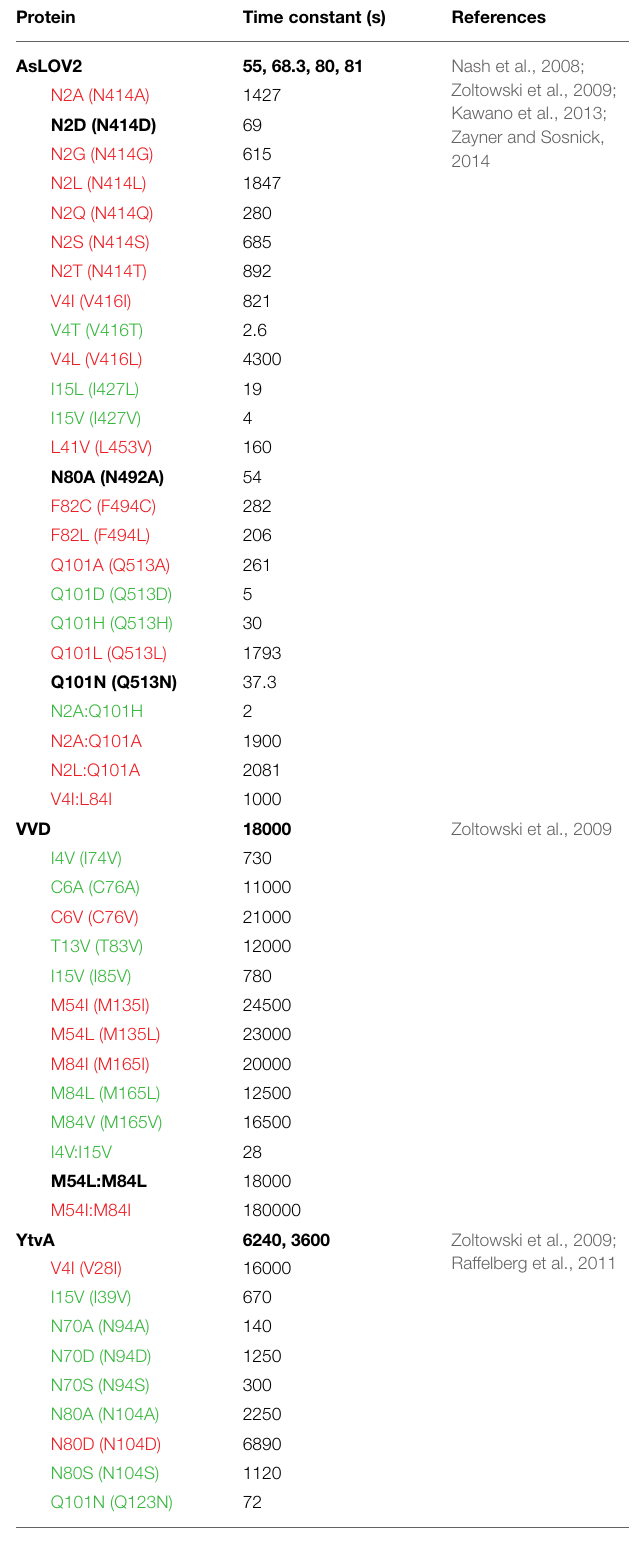
TABLE 2 | Kinetics of thermal reversion for LOV constructs and variants at 296 K. Protein Time constant